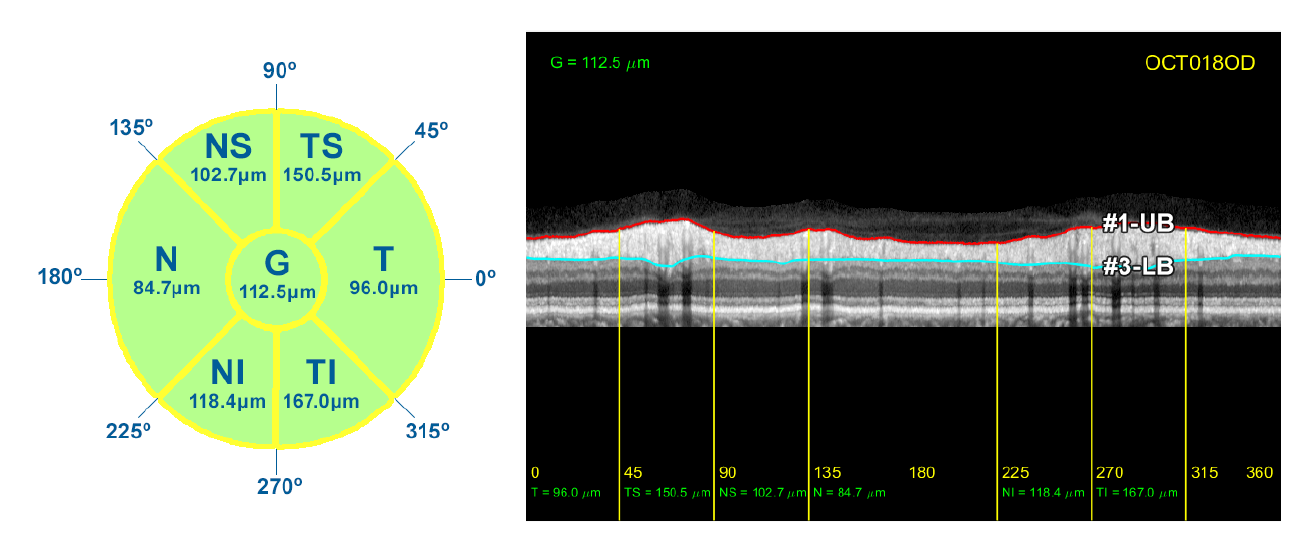
Figure 14. RNFL thickness measurements for each sector of the peripapillary circumference. On the left, diagram detailing the value of the average thickness of the RNFL in each sector of the eye. On the right side, representation of the borders #1-UB and #3-LB, and the average RNFL thickness in these